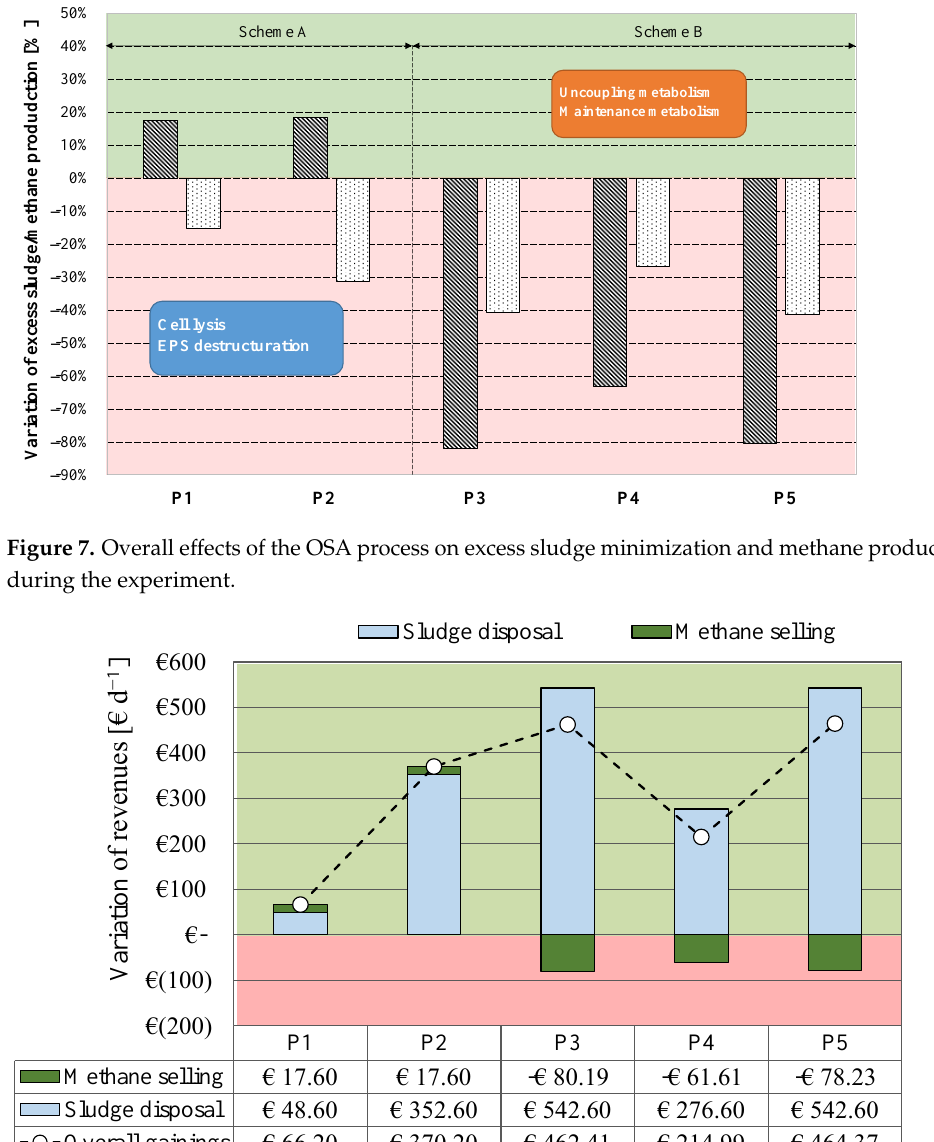
Figure 8. Variation of revenues related to sludge disposal cost and methane production ( posi- tive variation, negative variation).